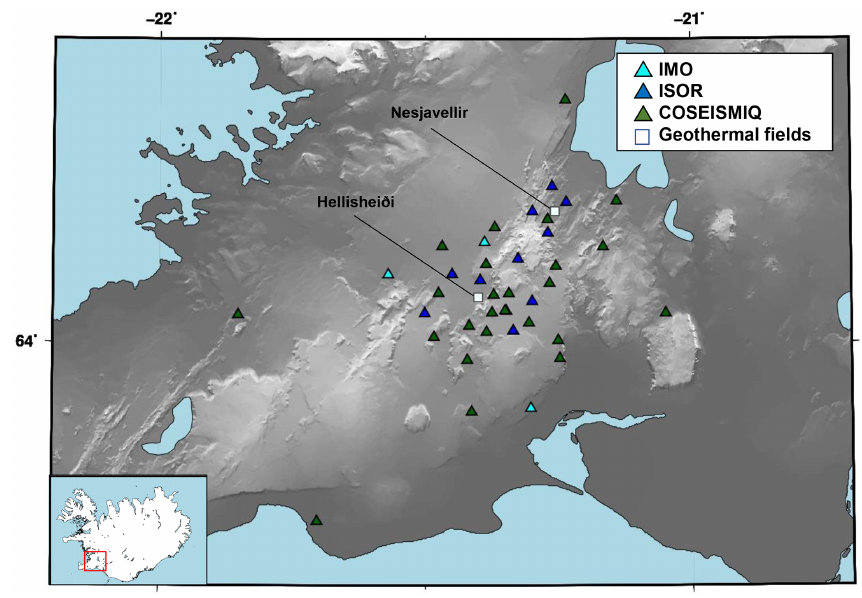
Figure 1. Seismic network considered here is composed by stations from IMO (light blue), ISOR (blue) and COSEISMIQ (green). The two Nesjavellir and the Hellisheidi geothermal field are marked with white